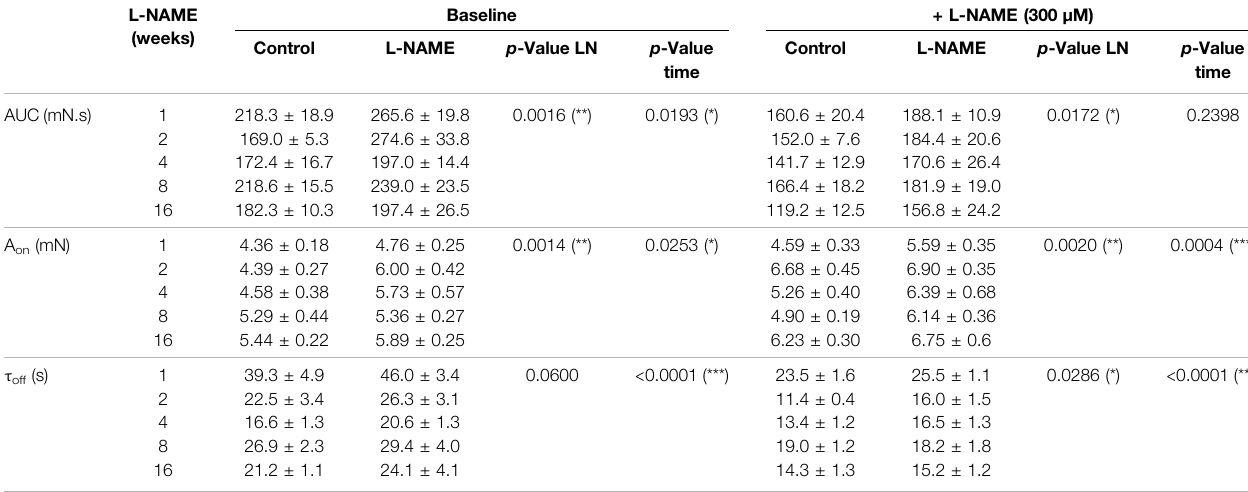
TABLE 1 | Chronic L-NAME treatment results in heightened SR-mediated contractions. L-NAME